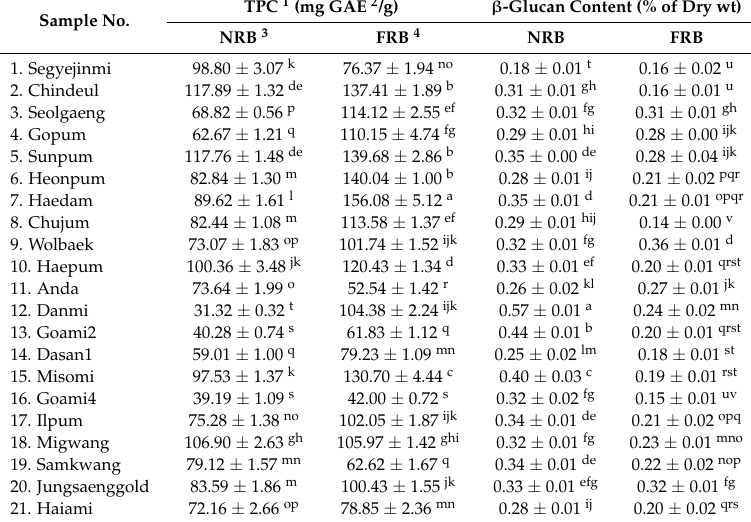
Table 3. β -glucan content and total phenolic content of 21 cultivars of rice bran by bioconversion. Sample